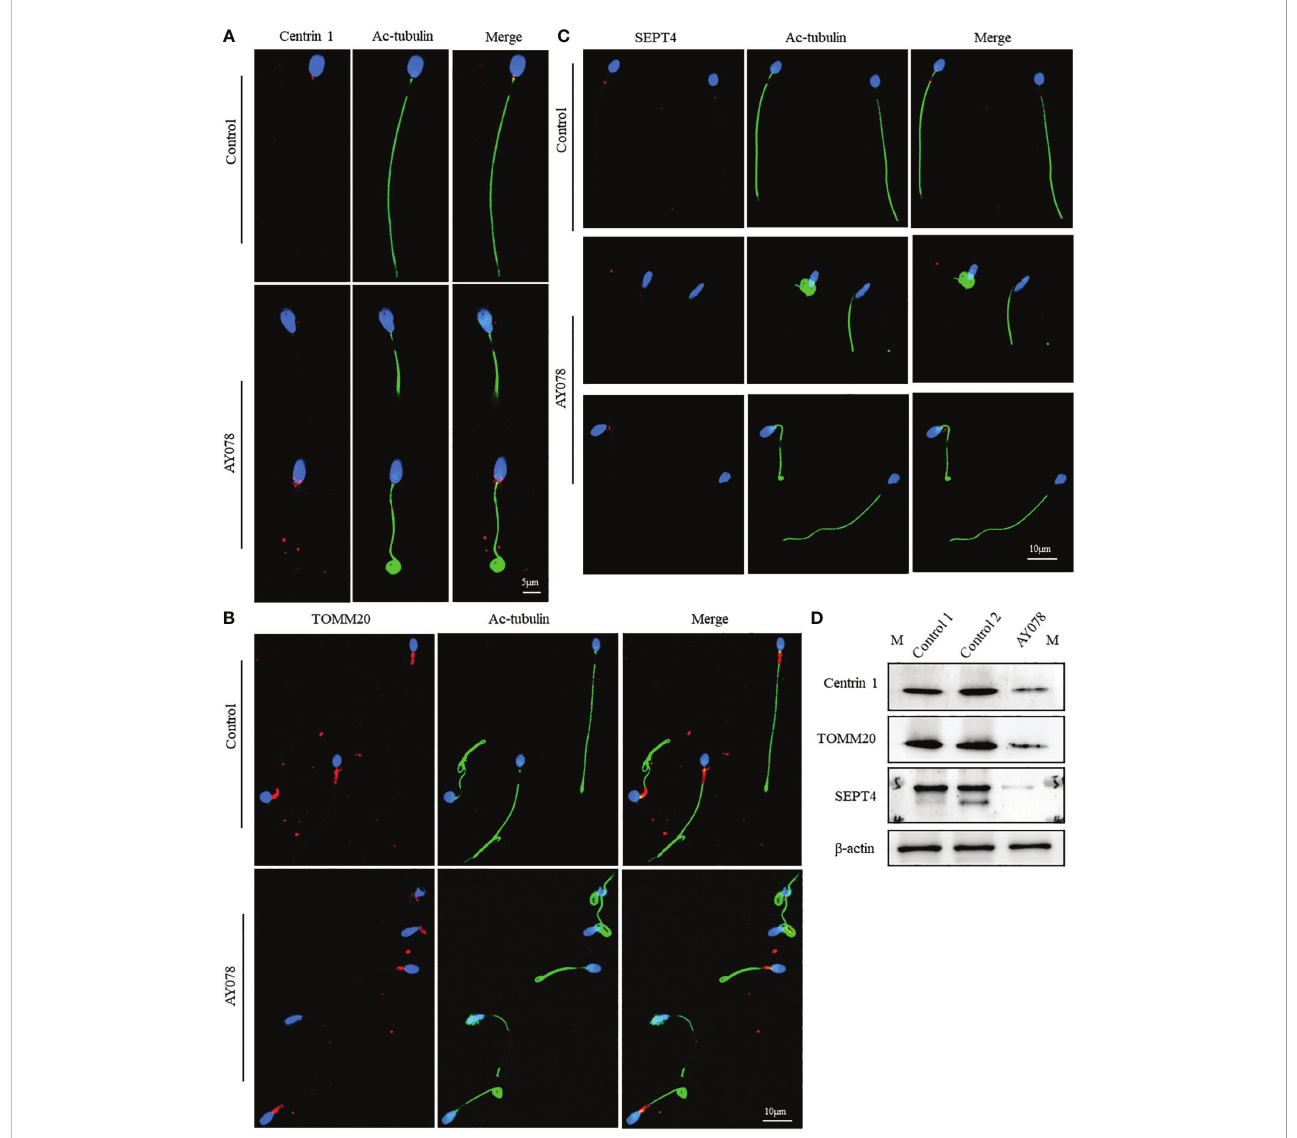
FIGURE 6 The distributionandexpressionof proteinsrelated tocentrosomeandmiddlepieceformationinAY078 andcontrol individual. (A – C) IFresultsonthe spermof AY078 andnormalsubject usinganti-Centrin1 ( redin A) , anti-TOMM20 ( redin B) andanti-SEPT4 ( redin C) . ItwasdemonstratedthatCentrin1expressat centriole, TOMM20 locate atmitochondrial sheath, andSEPT4 distribute onannulusringinnormal sperm.While, itwas foundthatdifferentdegreesof reductionof Centrin1, TOMM20 and SEPT4inspermfromAY078. Anti-ac-tubulin(green)markedthesperm fl agella, Hoechst(blue)markedthenucleusof spermatozoa.Scale bars:5 m m in (A) ,10 m min (B – D) WB assaysanalysis theexpressionlevelsofCentrin1,TOMM20and SEPT4inspermobtainedfromAY078 andnormalcontrol.The resultsof WBassayswere accordance withthoseof immuno fl uorescence assays describedabove. b